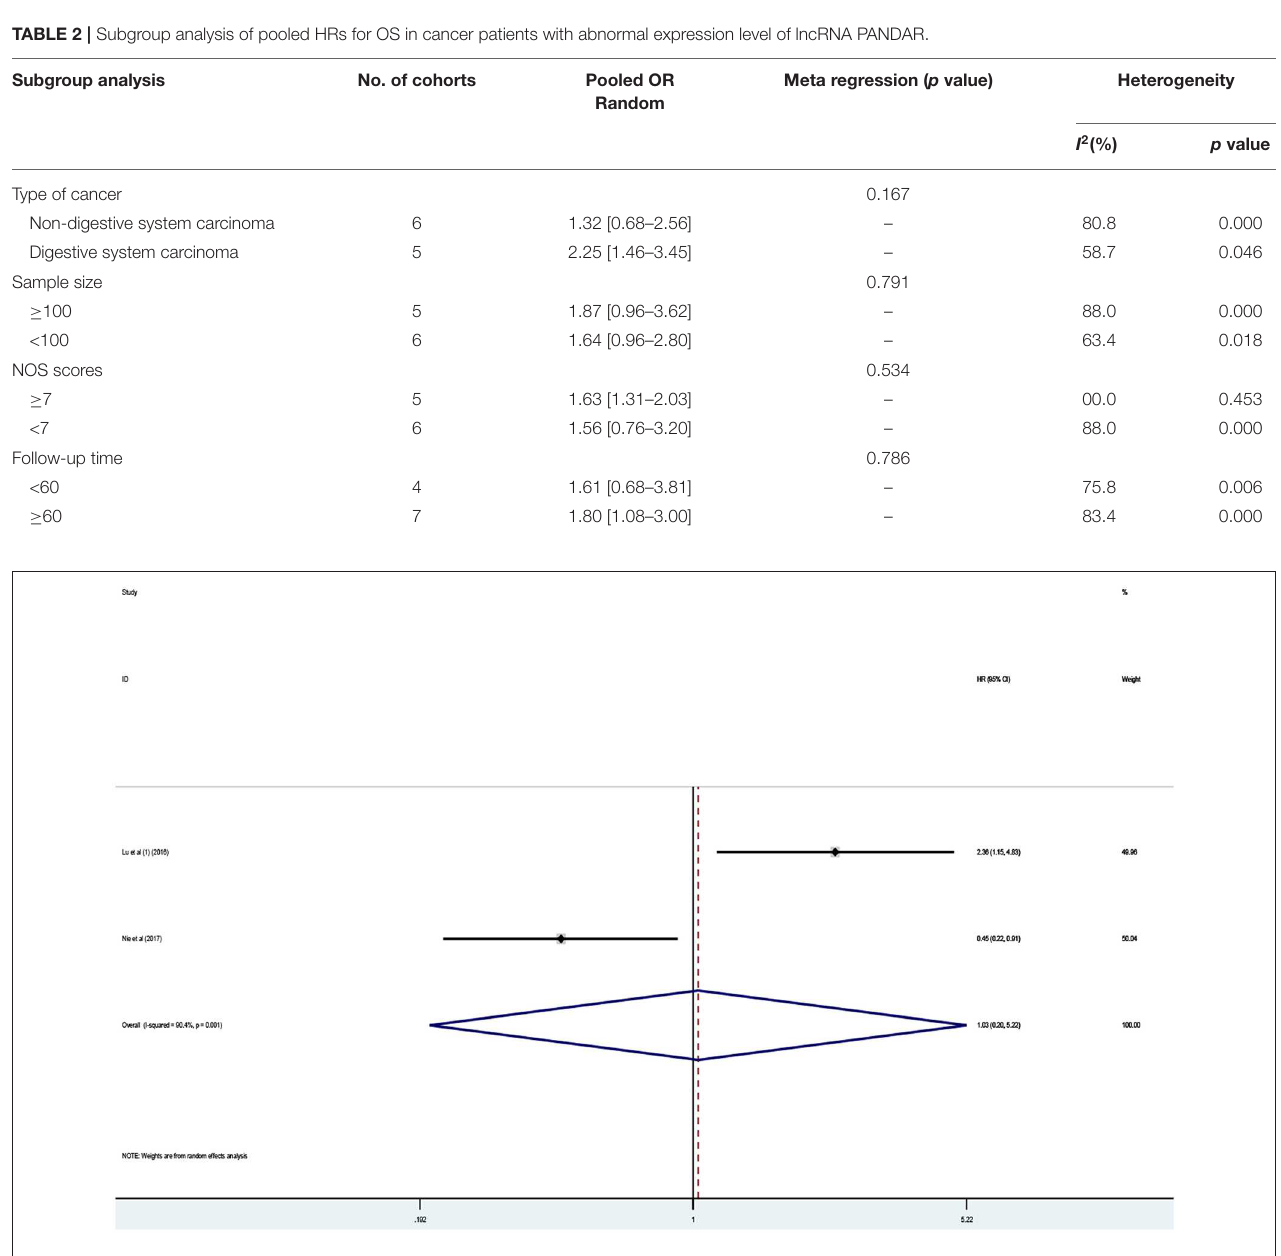
FIGURE 4 | Meta-analysis of the pooled HR of EFS for malignancy